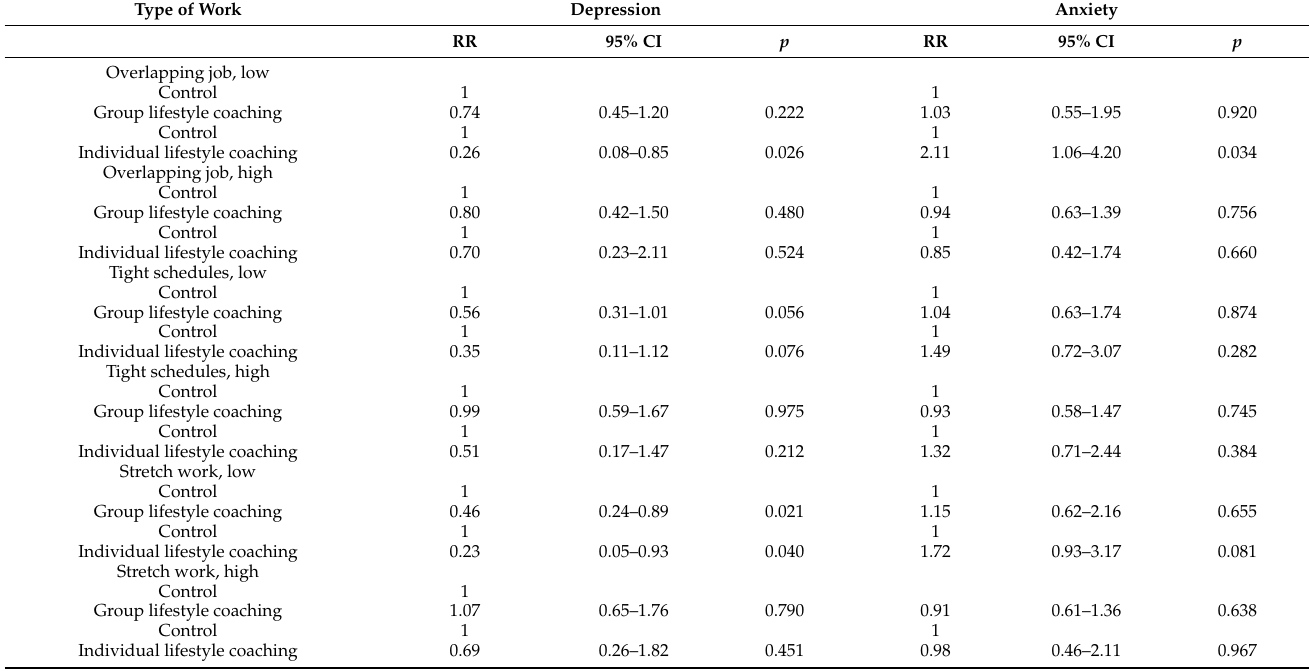
Table 4. The results of imputed data on the effects of lifestyle coaching on depression and anxiety among participants with low or high overlapping jobs, tight schedules, and stretching